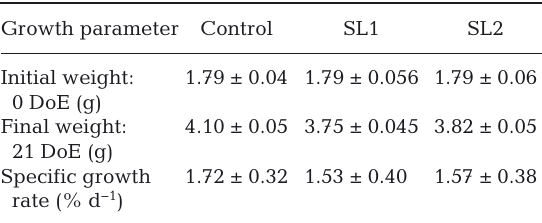
Table 3. Growth (mean ± SD) of juveniles of Litopenaeus vannamei recorded in treatment and control aquaria during chronic exposure experiment with chlorpyrifos. DoE: days of exposure. SL1 (2) as in Table